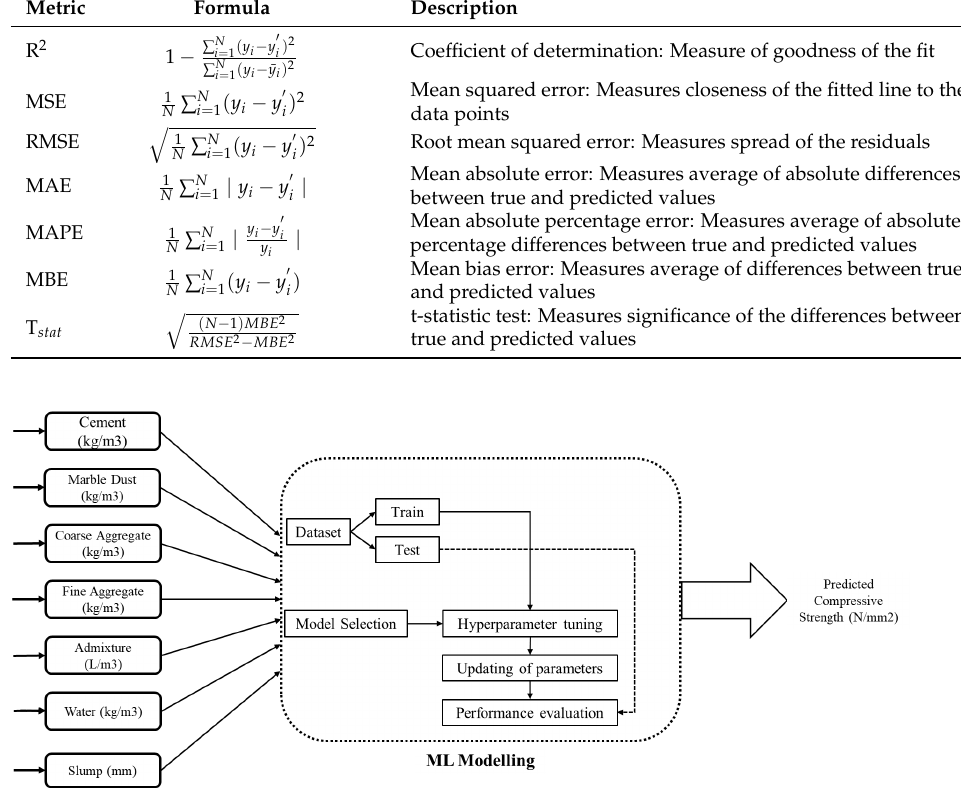
Figure 2. Process flow for various ML